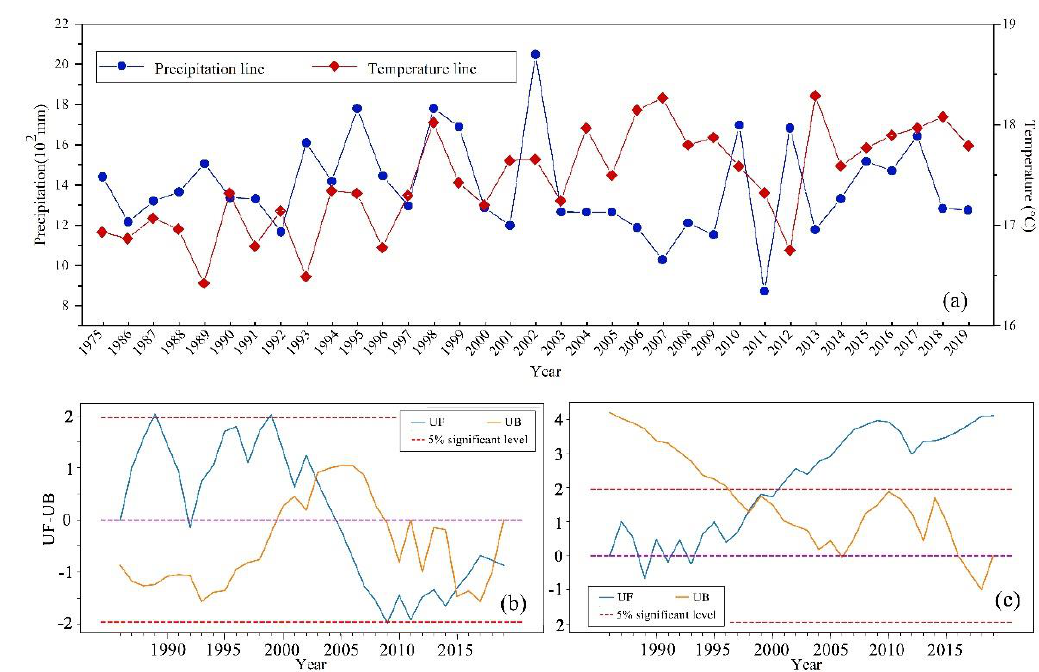
Figure 6. Annual changes of rainfall and air temperature from 1975 to 2019: ( a ) changes of rainfall and temperature; ( b ) M-K test result for rainfall; and ( c ) M-K test result for air temperature. Table 5. Correlation analysis of the relationship between surface water and